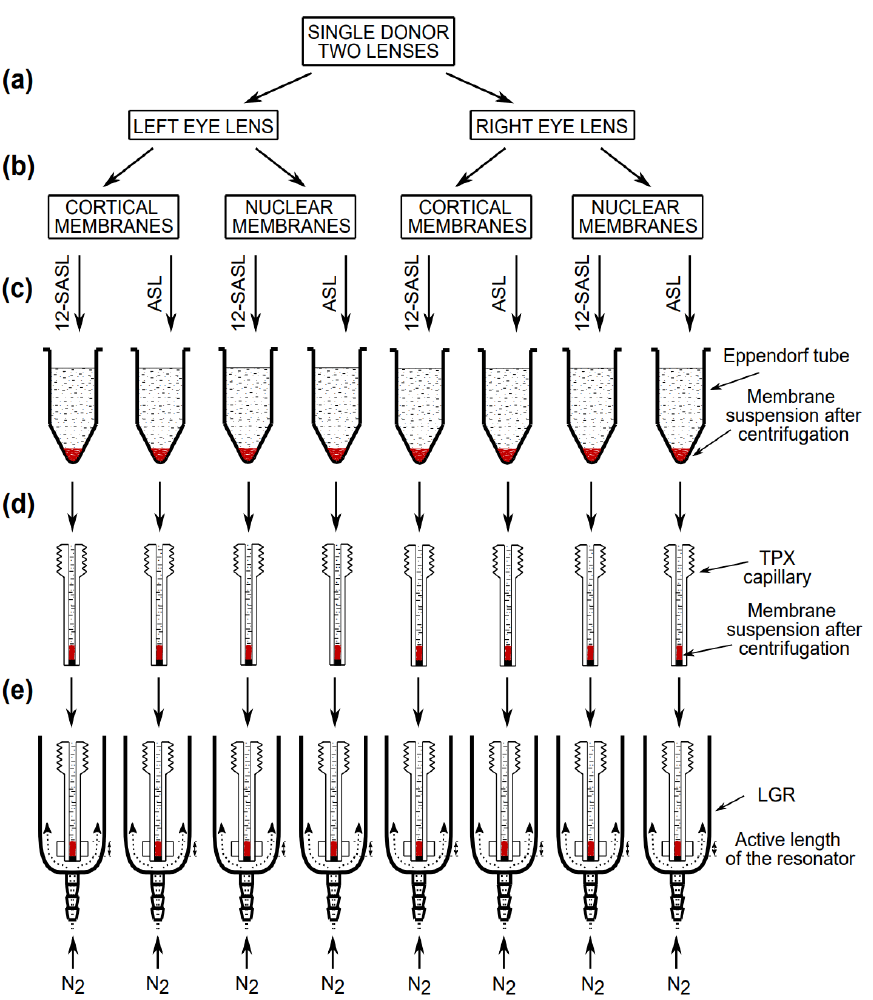
Nine pairs of human lenses from donors of different ages, i.e., 15-year-old (female, white/Caucasian), 21-year-old (male, white/Caucasian), 36-year-old (male, white/Caucasian), 40-year-old (male, white/Caucasian), 46-year-old (male, white/Caucasian), 53-year-old (female, Black), 60-year-old (male, white/Caucasian), 65-year-old (male, white/Caucasian), and 70-year-old (male, white/Caucasian), were obtained from the Lions Eye Bank of Wisconsin. Lenses were removed in situ from bodies within an average time frame of 9 h postmortem. Human lenses were stored at − 80 ◦ C until intact, cortical, and nuclear membranes could be isolated. A binocular microscope was used to examine the lenses, and presence and absence of cataractous changes were evaluated using a subjective grading system based on the opacity of the lens for the cortical cataracts and amount of “yellowness” of the lens for the nuclear cataracts. The nuclear cataracts were detected in both the left and right eyes of the 60-, 65-, and 70-year-old donors, and a cortical cataract also was detected in the right eye of the 60-year-old donor. All other lenses were free of cataracts. The intact, cortical, and nuclear membranes from single human lenses were isolated and stored at − 20 ◦ C as described previously [8–10,15]. The separation of the cortex from the nucleus is presented schematically in Figure 2a,b.